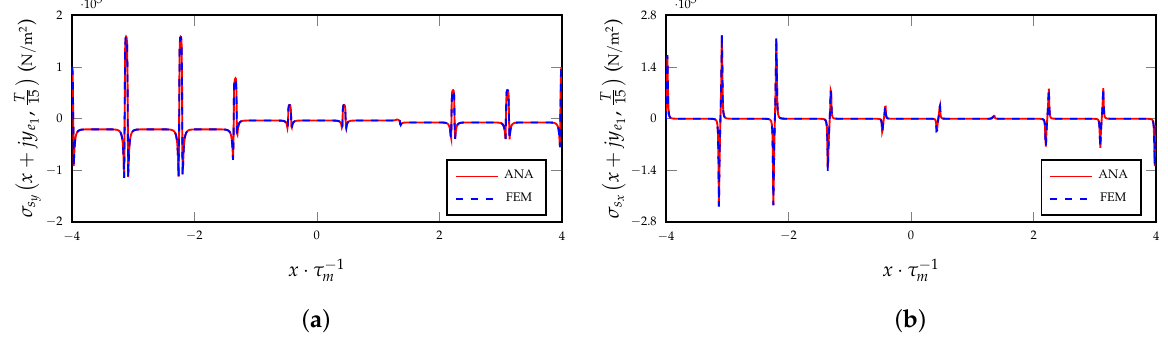
Figure 15. Analytical and FEM armature reaction Maxwell tensor for the slotted machine of Figure 4a = g − δ / 2 for t = T/15 ( − 4 τ m ≤ x ≤ 4 τ m N x = 10,000, N on the exploration line at y e 1 I pk = 105.5 A ): ( a ) normal component; ( b ) tangential